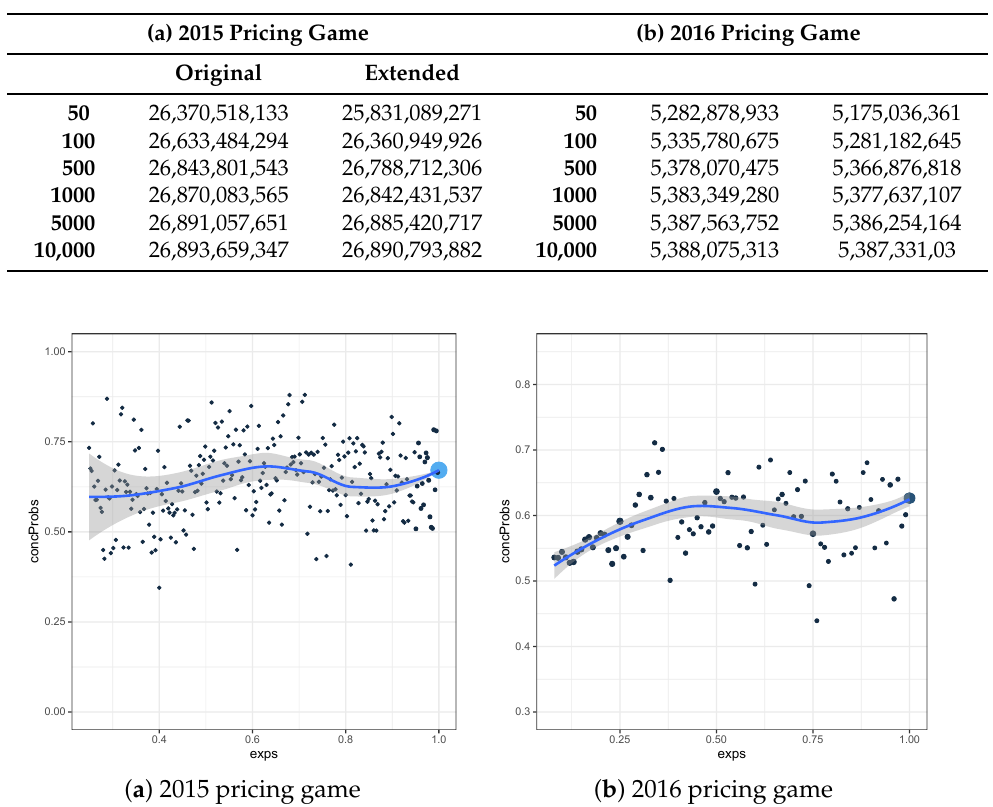
≈ ( λ ,0.05 ) based on the dataset of the 2015 and 2016 pricing Figure 5. Weighted-mean-plot for ˆC M ,0,1 + game. It is obtained by the original marginal approximation, using the same 50 boundary values for the O - and 1 -group.